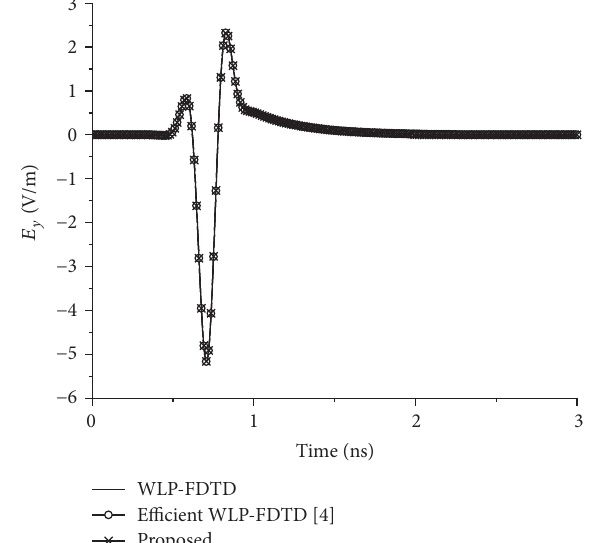
Figure3:Transientelectricfieldsofthevector 𝑦 at 𝑝 ( 100Δ𝑥 , 65Δ𝑦 ).